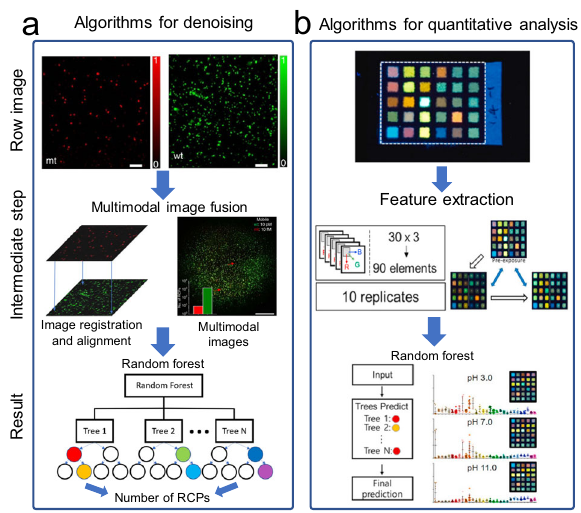
Fig. 6 | Traditional machine learning algorithms for mHealth platforms. a Algorithms for denoising. The fi gure illustrates the use of a random forest approach to differentiate real ampli fi cation signals from background noise after multimodal image fusion ( fi gure adapted with permission from Kuhnemund et al. 10 ). b Algorithmsforquantitativeanalysis.The fi gureillustratestheuseofarandom forest algorithm for colorimetric analysis and high-precision pH measurements ( fi gure adapted with permission from Kim et al. 96